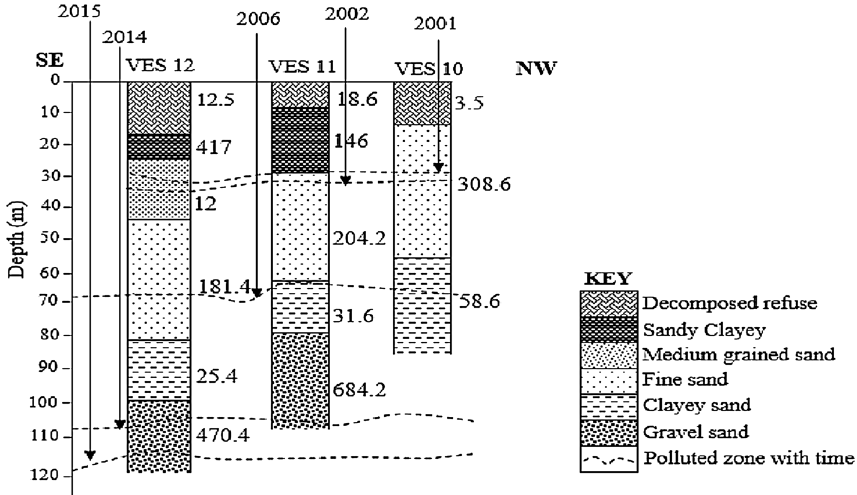
Fig. 5 Geoelectric section around profile 1 showing pro- gressive increase in the depth of migration of leachate from 2001 through 2015 on the Olusosun dumpsite